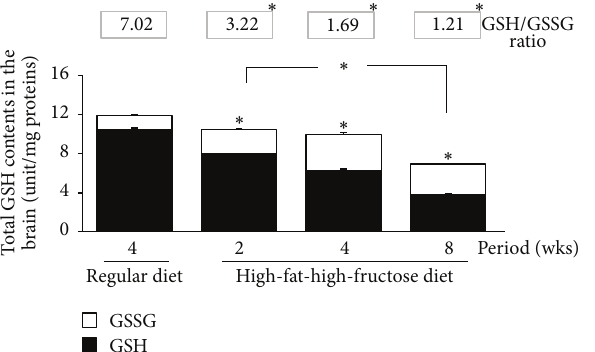
Figure 8: Effects of a high-fat, high-fructose diet on the total GSH, reduced GSH, and GSSH content and the GSH/GSSG ratio in the mouse brains. Mice were fed a commercial standard diet for 4 weeks, and a high-fat, high-fructose diet (HFFD) was administered intragastrically for 2, 4, or 8 weeks. The mice were sacrificed 24h after the last treatment; their brains were immediately excised to determine the total glutathione, reduced GSH (black column), and GSSG (white column) content, and the GSH/GSSH ratio was then calculated (digit above the graph). The data are presented as the mean ± SD ( 𝑛 = 5 ). Significant differences were determined using a one-way analysis of variance (ANOVA) followed by Tukey’s post hoc test. ∗ 𝑝 < 0.05 versus the regular diet mice.